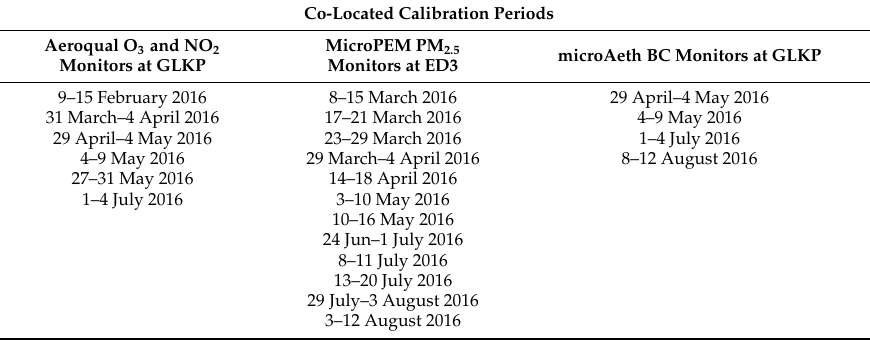
Table 1. Dates of co-locations of portable monitors with reference analysers. GLKP = Glasgow Townhead urban background Automatic Urban and Rural Network (AURN) site. ED3 = Edinburgh St. Leonard’s urban background AURN